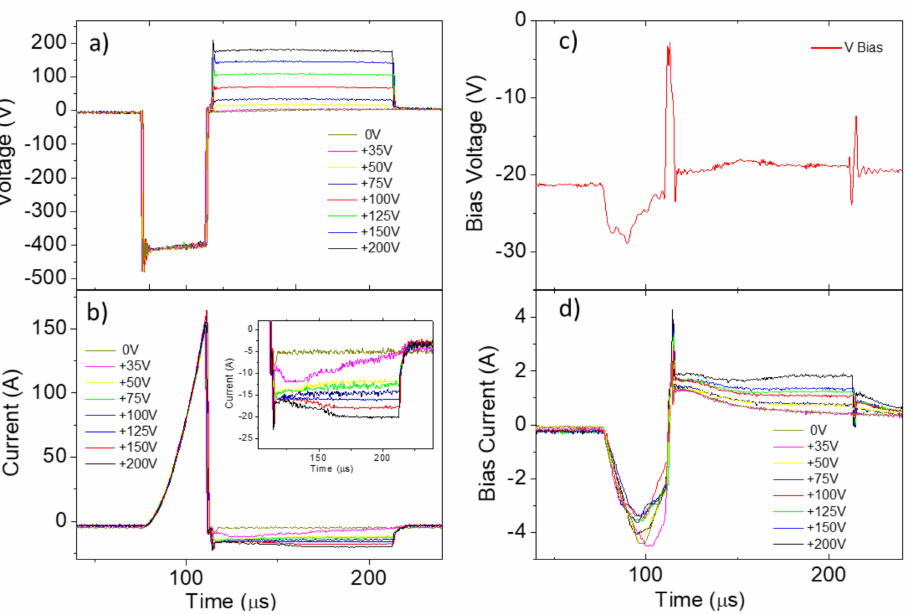
Figure 3. Left : Voltage ( a ) and current ( b ) waveforms for the magnetron during Nb operation. Right : Voltage ( c ) and current ( d ) waveforms for the Bias during Nb operation.